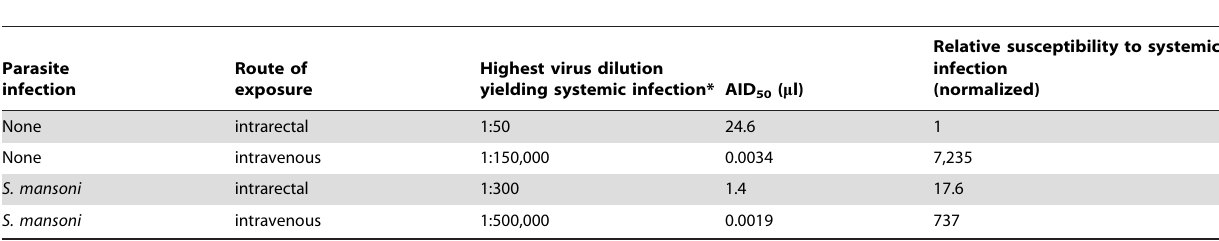
* defined by plasma viral RNA load . 10 4 copies/ml.